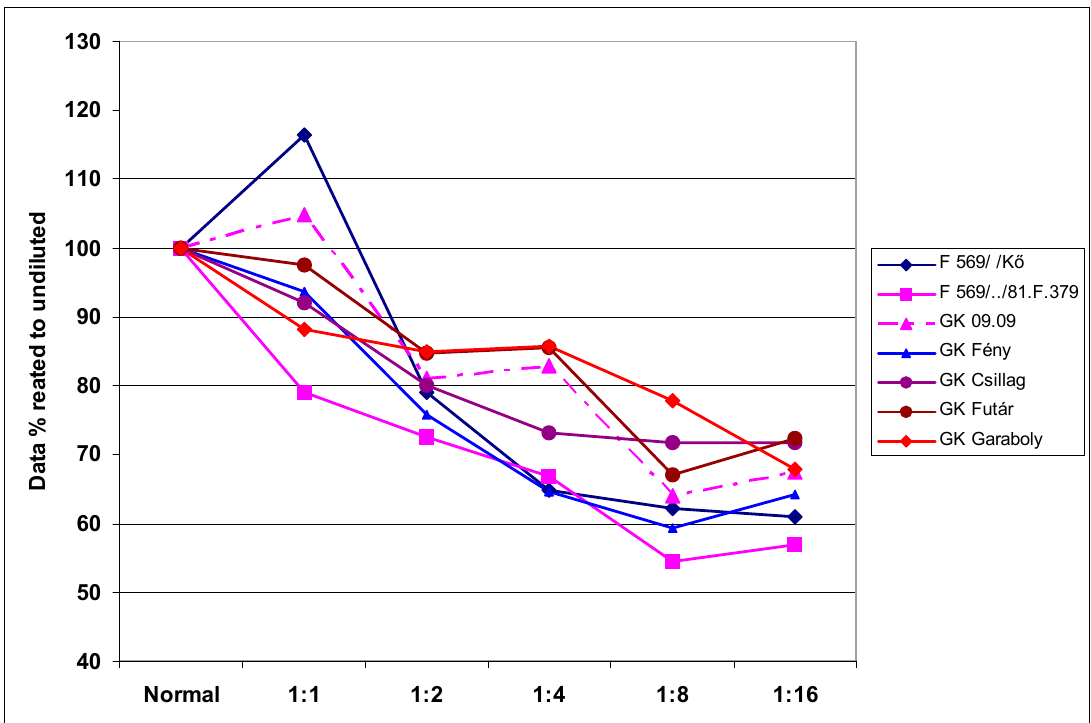
Figure 2. Evaluation of disease response of winter wheat genotypes to dilution at different dilution rates related to the non-diluted original inoculum (100%), visual symptoms DI%, across isolates, 2013–2014.